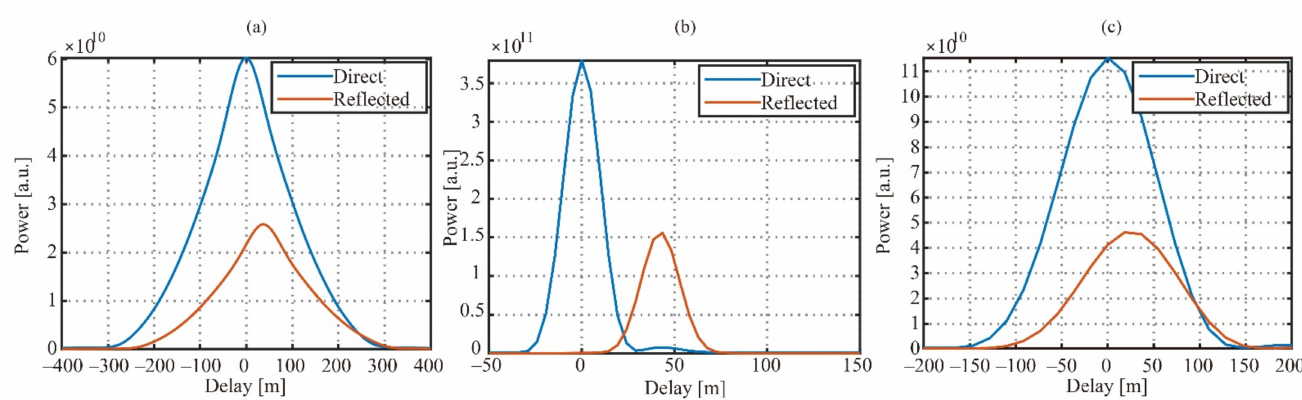
Figure 6. Examples of the measured delay waveforms, before interpolation, of ( a ) GPS L1 C/A signals, ( b ) GPS L5 signals, and ( c ) BDS B1 signals. The delay waveforms of GPS and BDS are generated from the raw data collected at 14:57 on 30 October 2020 and 11:10 on 3 August 2018, respectively. The signals are transmitted by GPS PRN 24 satellite with an elevation angle of 49.72 ◦ and BDS PRN 01 satellite with an elevation angle of 44.58 ◦